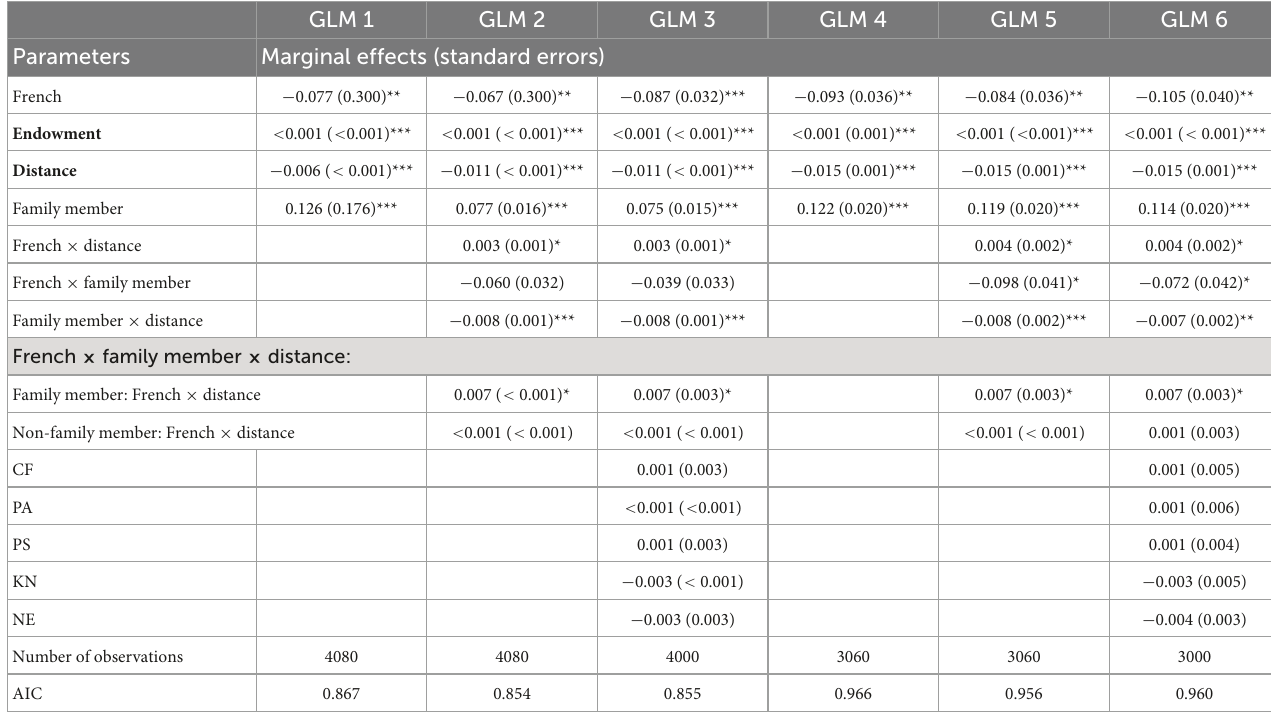
TABLE 6 Generalized linear models predicting social discounting behavior. GLM 1 GLM 2 GLM 3 GLM 4 GLM